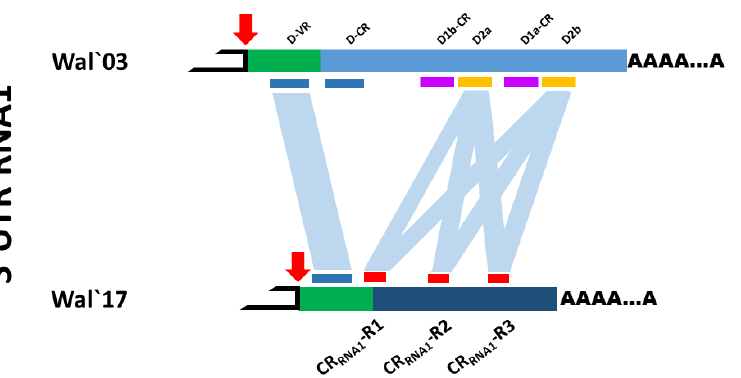
Figure 1. Schematic comparison of 3’untranslated regions of RNA1 of ToTV-Wal’03, and ToTV-Wal’17. The repetitive motifs were indicated with blue (D-VR, D-CR), violet (D1b-CR, D1a-CR), orange (D2a, D2b) (ToTV-Wal’03), and red (ToTV-Wal’17) bars. The red arrow marks the stop codon. The green blocks are common 3’UTR regions for both isolates. The D-VR D-CR regions (the blue bars) are present together only in the genome of ToTV-Wal’03. In RNA1 3’UTR of ToTV-Wal’17 only the D-VR region was identified. The RNA2 3’UTR of ToTV-Wal’17 shares 99% identity with the corresponding region of ToTV-Wal’03 and in the CR region, the repetitive motifs D1b–D2a–D1a–D2b were still present. Additionally, performed phylogenetic studies based on the 3’UTR of RNA1 and RNA2 confirmed the results from comparative sequences studies mentioned above. In the dendrogram generated based on 3’UTR RNA1, we showed that the ToTV-Wal’17 isolate clustered with the recently reported South African ToTV isolate, and they both are phylo- genetically distant from the other Polish and Spanish isolates of ToTV. The 3’UTR of RNA2 sequence analysis showed that the ToTV-Wal’17 clustered together with the ToTV- Wal’03 and had a short evolutionary distance with other Polish and Spanish isolates (Fig- ure 2).